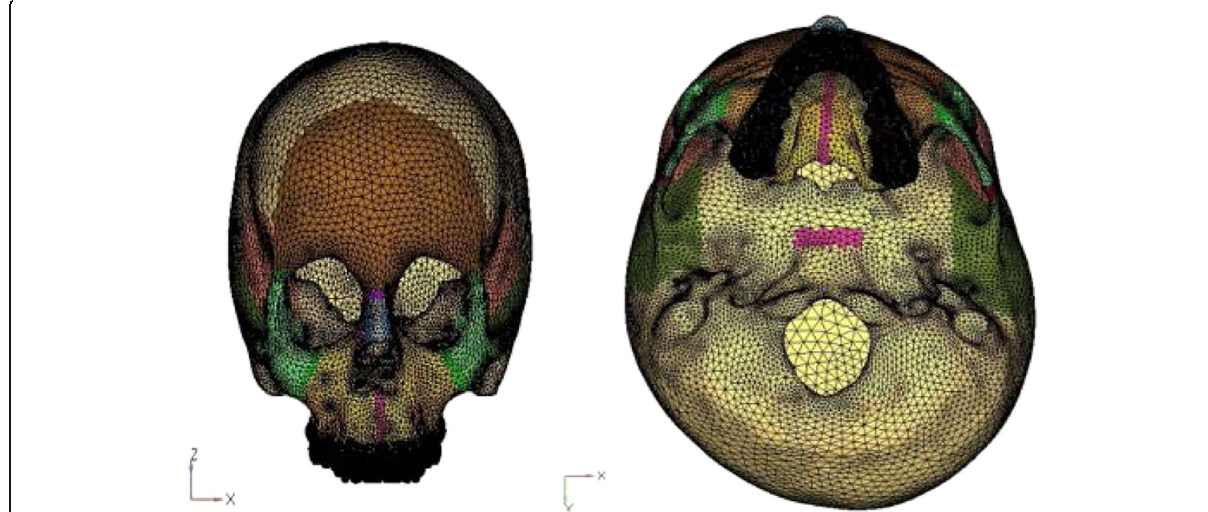
Fig. 3 Finite element model of the skull